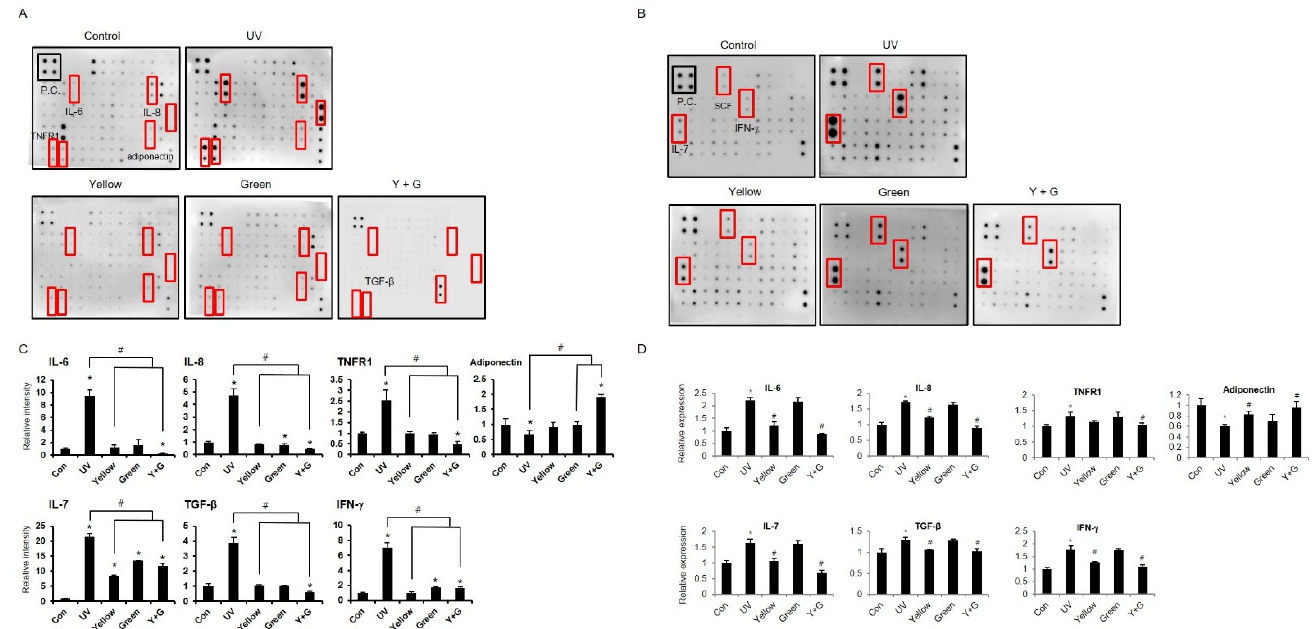
Figure 2. IPL treatment attenuates the ultraviolet B (UVB)-induced hyperimmune response. ( A , B ) IPL-treated normal human epidermal keratinocyte (NHEK) culture medium was harvested for a cytokine array. Representatively changed cytokines and positive control spots are highlighted. ( C ) The relative intensity of cytokines was represented. ( D ) The relative expression of cytokines that were altered in the array was measured by RT-qPCR. The results are shown as the means ± SDs of the values obtained in 3 independent experiments (N = 3). # p < 0.01 compared to the UVB-treated group; * p < 0.001 compared to the control